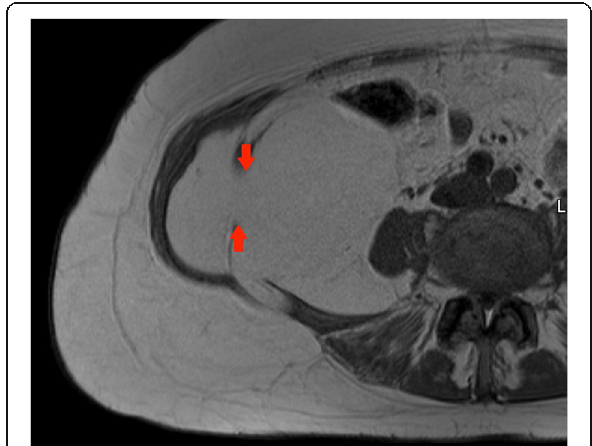
Fig. 8 Axial T1-weighted MRI of the pelvis and lower abdomen: Large right sided lipomatous tumour extends laterally splitting the transversalis fascia and extends into the fascial planes of the obliques